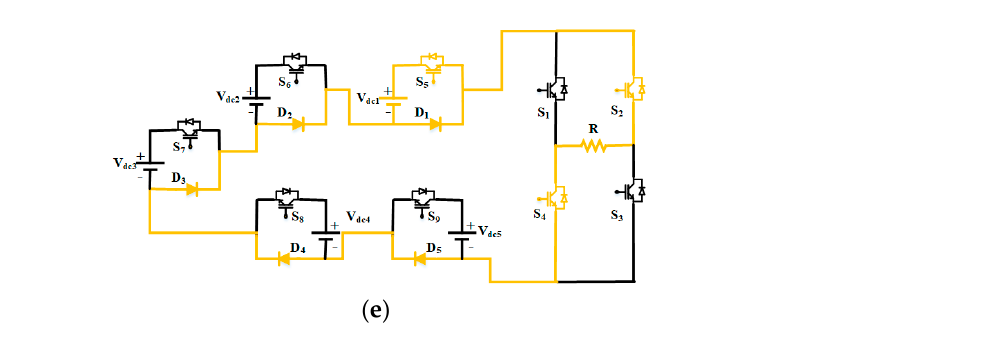
Figure 19. Pulse waveforms and output voltage waveform of the proposed inverter.